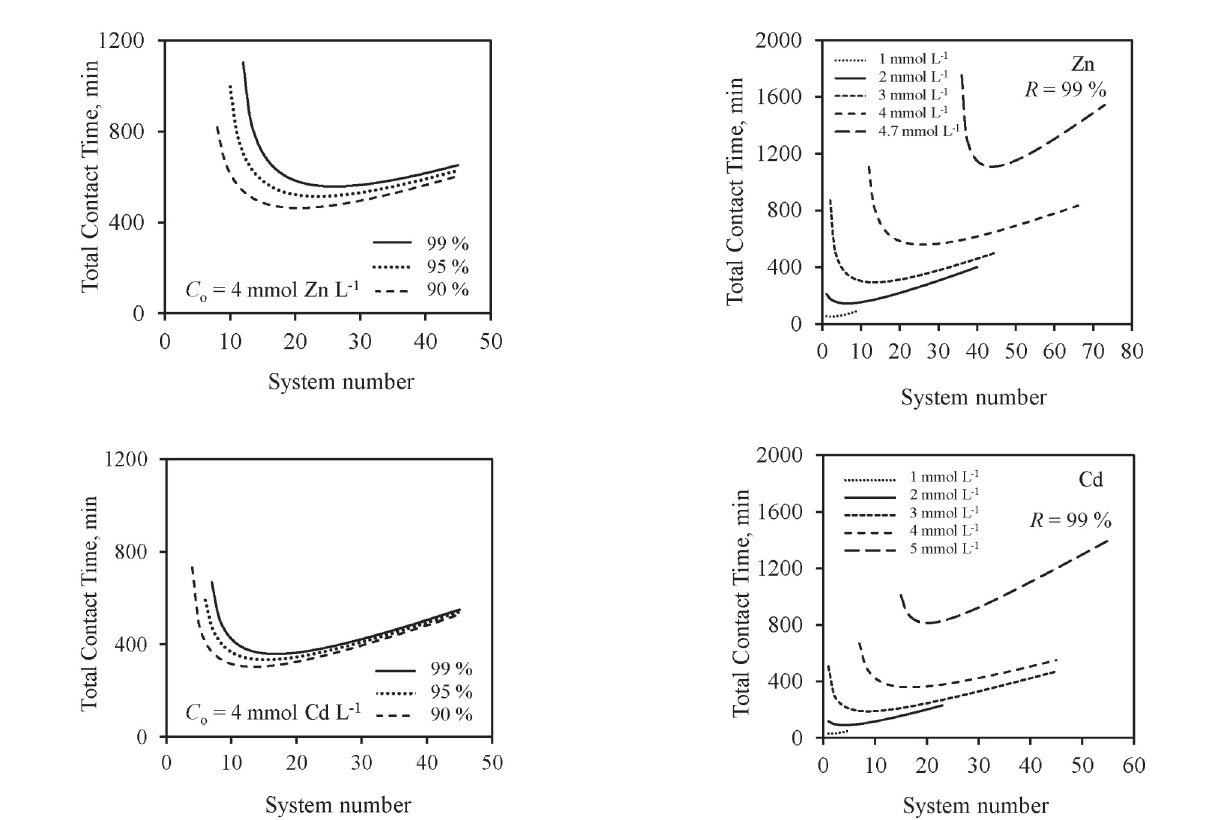
Fig. 8 – Minimum contact time for various percentage re- movals for the initial concentration of 4 mmol L –1 of zinc and cadmium